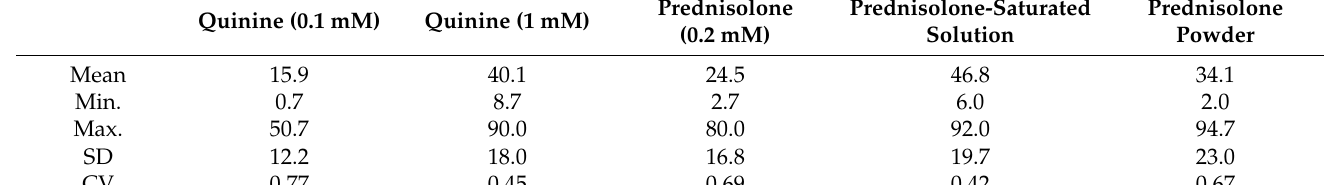
Table 2. The gLMS bitterness rating scores by subjects ( n = 50) for the bitter taste of each stimulus.